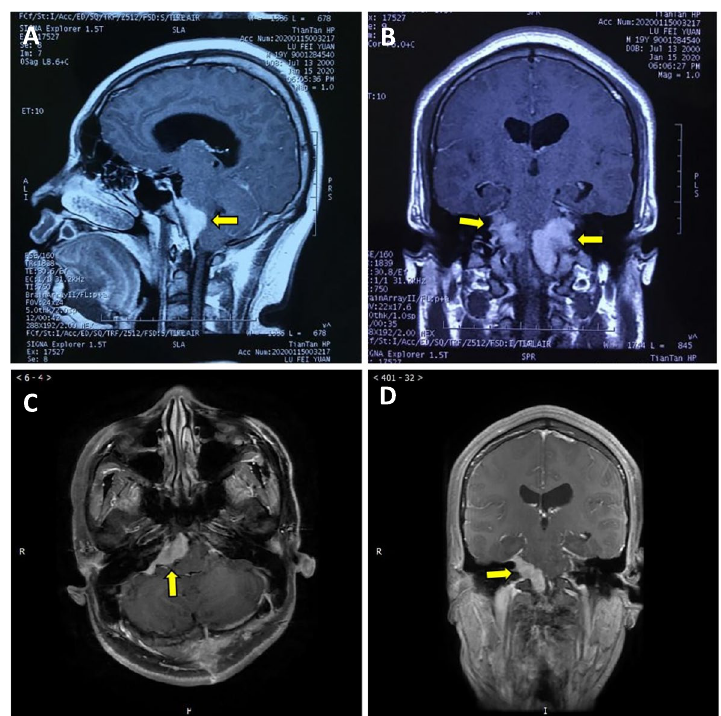
Fig. 1 Cranial MRI contrast before and after recurrence. A Enhanced MRI (sagittal view) before recurrence; B Enhanced MRI (coronal view) before recurrence; C Enhanced MRI (transverse sections of the brainstem) after recurrence; D Enhanced MRI (coronal view) after